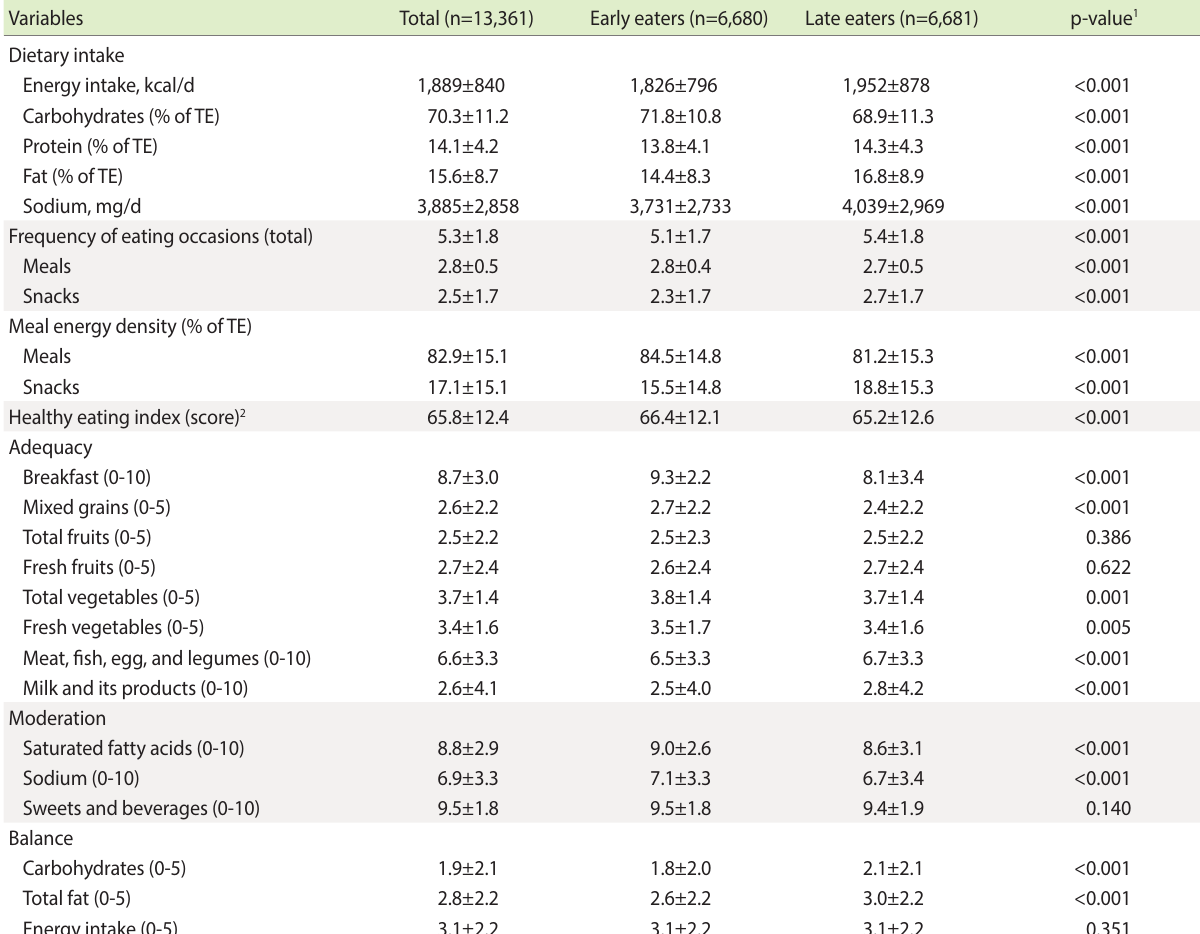
Table 2. Dietary profiles according to late eating in adults with hypertension